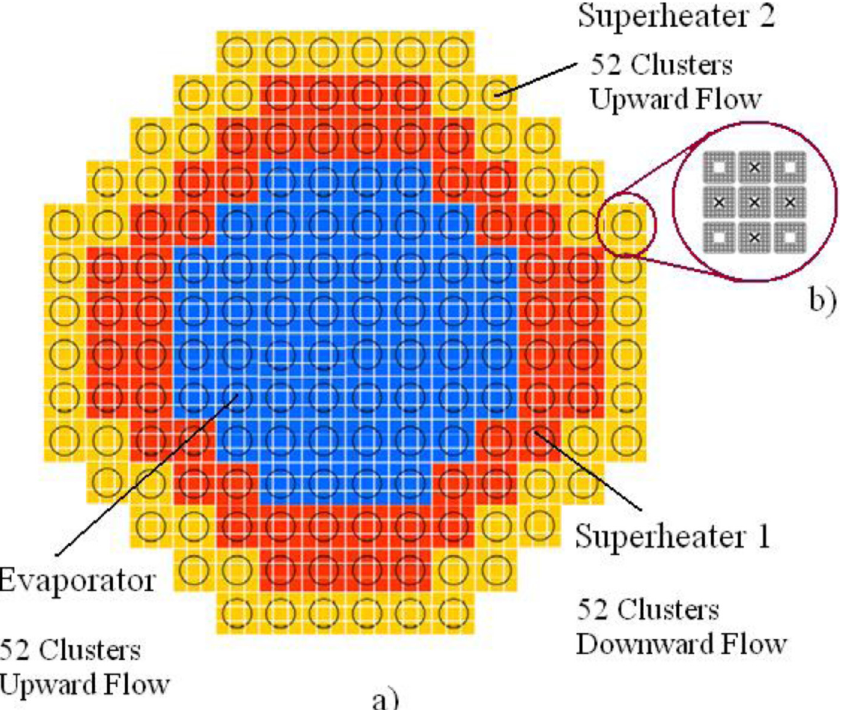
Fig. 4. (a) Arrangement of evaporator, superheater 1, superheater 2, and assembly clusters in the core, (b) assembly cluster with water tubes and control rods.